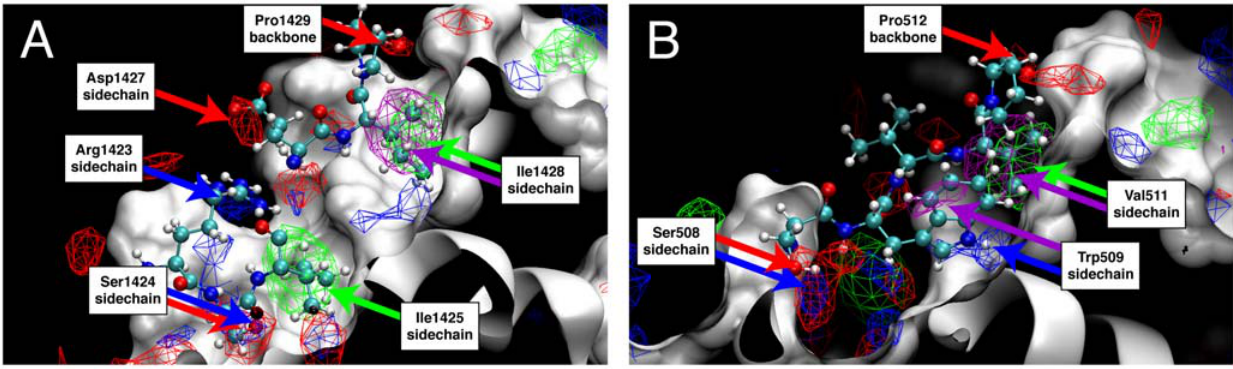
Figure 5. SILCS FragMaps for BCL-6 overlapping with the C-terminal residues of the SMRT and BCOR peptides. The molecular surface of the BCL-6 protein from the BCL-6:SMRT cocrystal is shown in white. High-probability isosurfaces from the FragMaps are represented as meshes, with the aliphatic carbon FragMap in green, the aromatic carbon in purple, the hydrogen bond donor in blue, and hydrogen bond acceptor in red. Thermodynamically important residues in (A) the SMRT peptide and (B) the BCOR peptide are shown as sticks, and the residue/FragMap overlaps are labeled.